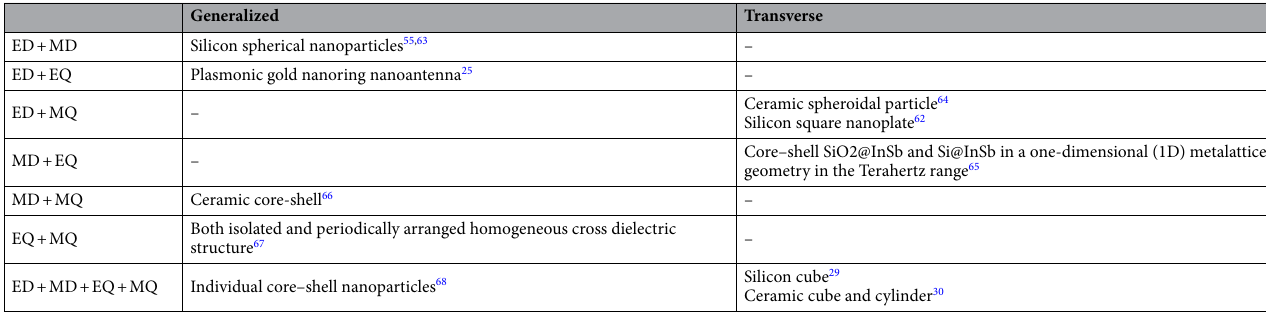
Table 1. Examples demonstrating various Kerker-type effects for different shapes and material of